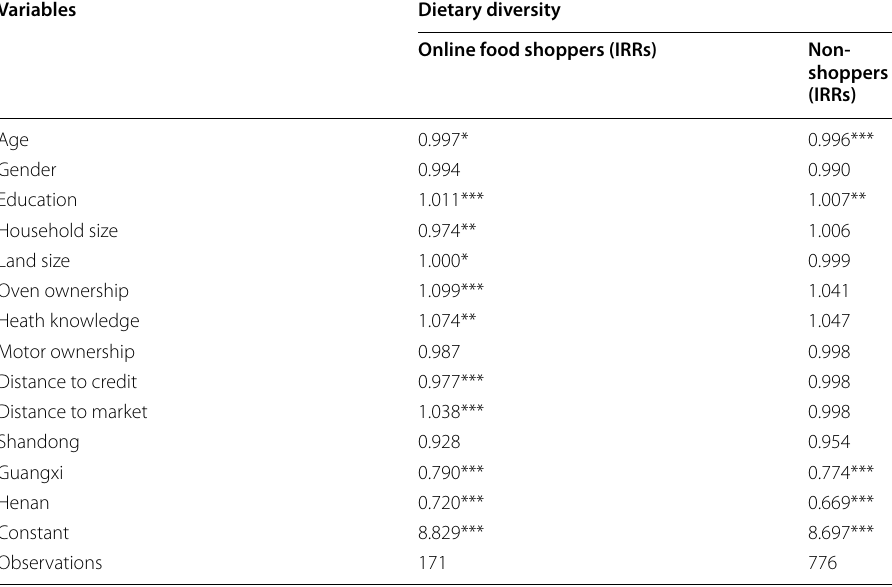
Table 5 Determinants of dietary diversity for online food shoppers and non-shoppers: IRR